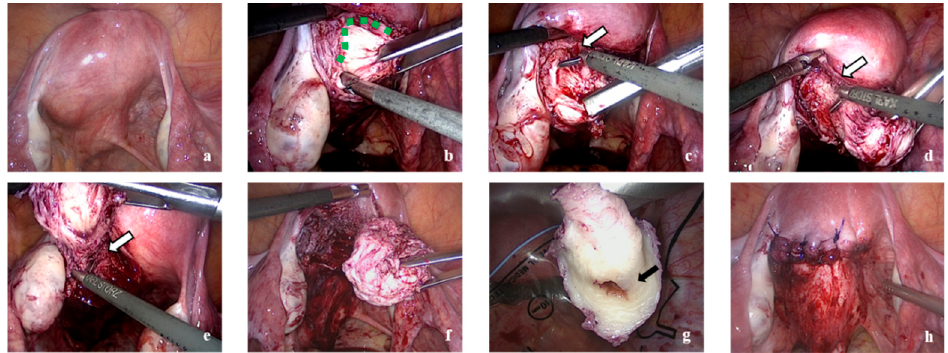
Figure 4. ( a ) A bulge is seen over the left side, posterior uterine myometrium. ( b ) The boundary of adenomyotic tissue and normal myometrium (green dotted line). ( c–e ) Resection for fibrotic tissue as the border between adenomyotic tissue and normal myometrium with the scissor forceps (white arrow). ( f ) The cyst could gently be removed without rupture. ( g ) Black arrow indicating the cystic capsule with the chocolate fluid. ( h ) Wound was repaired after cystectomy.